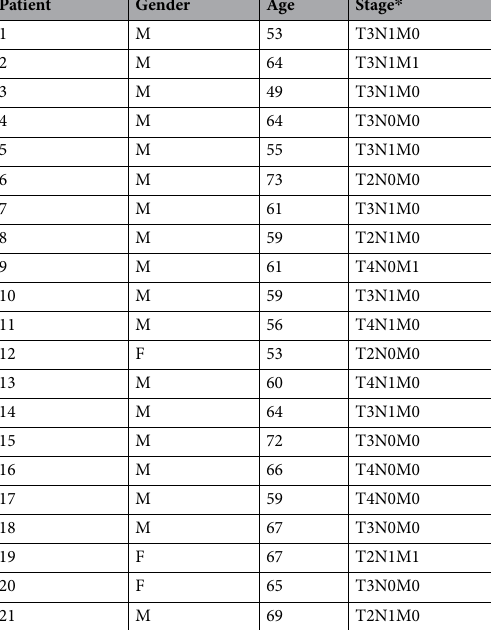
Table 1. Basic characteristics of 21 patients with EC. Abbreviations: M = Male; F = Female. Note: * According to American Joint Committee on Cancer (AJCC), 6 th